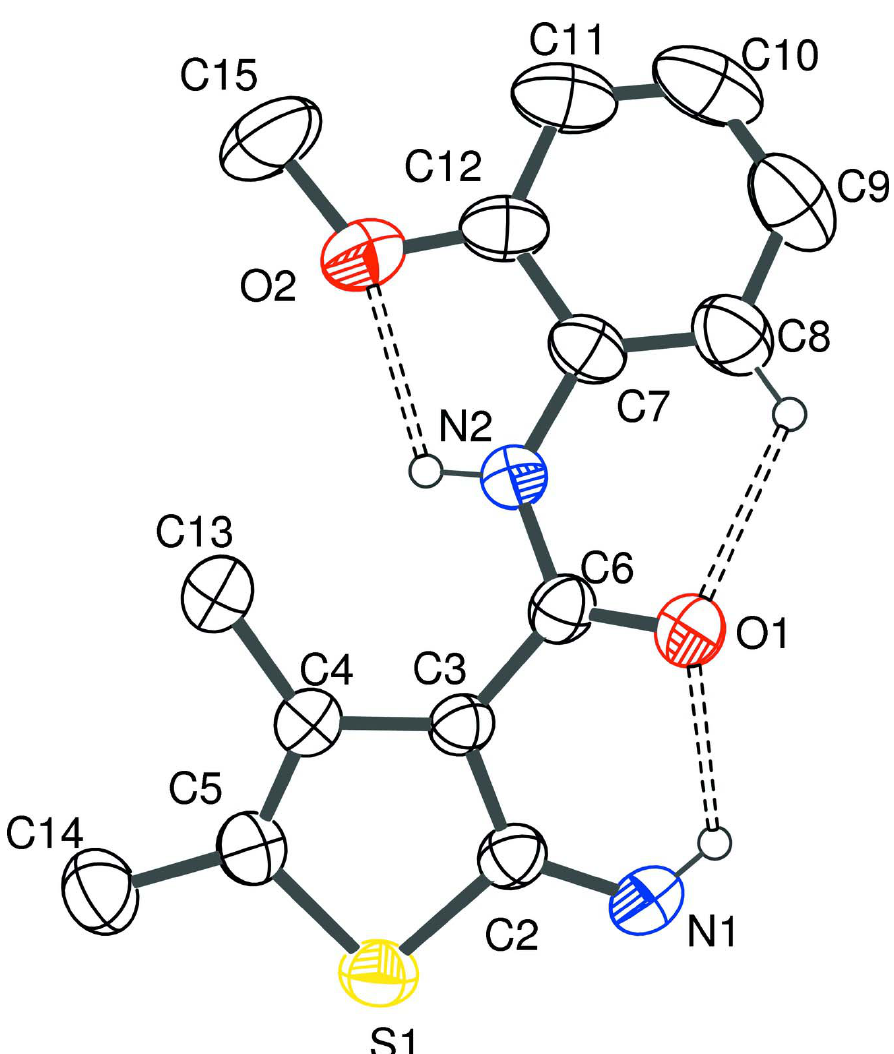
Figure 1 The molecular structure of (I), with atom labels and 50% probability displacement ellipsoids for non-H atoms.Dashed lines indicate intramolecular hydrogen bonds; H atoms not involved in hydrogen bonding have been